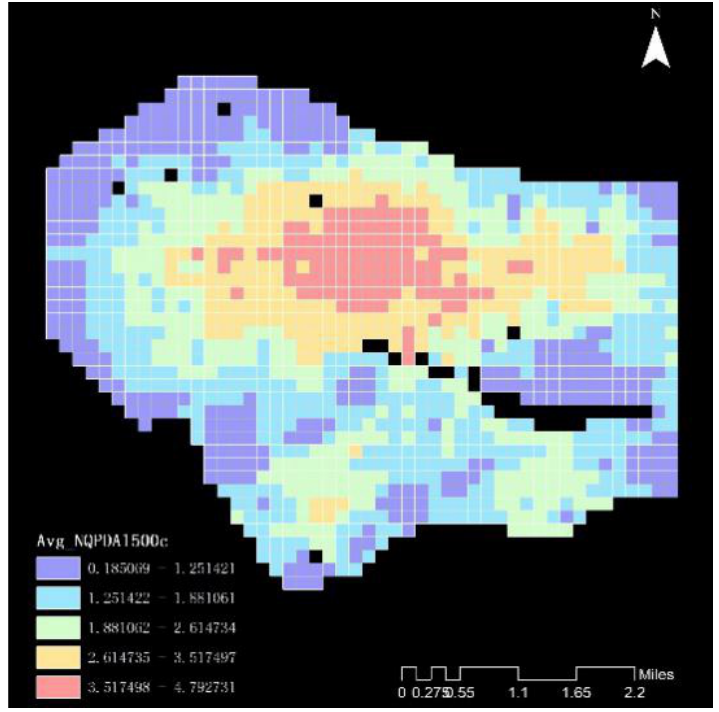
Fig. 7 Fishing net graph of the regional closeness of 1500m